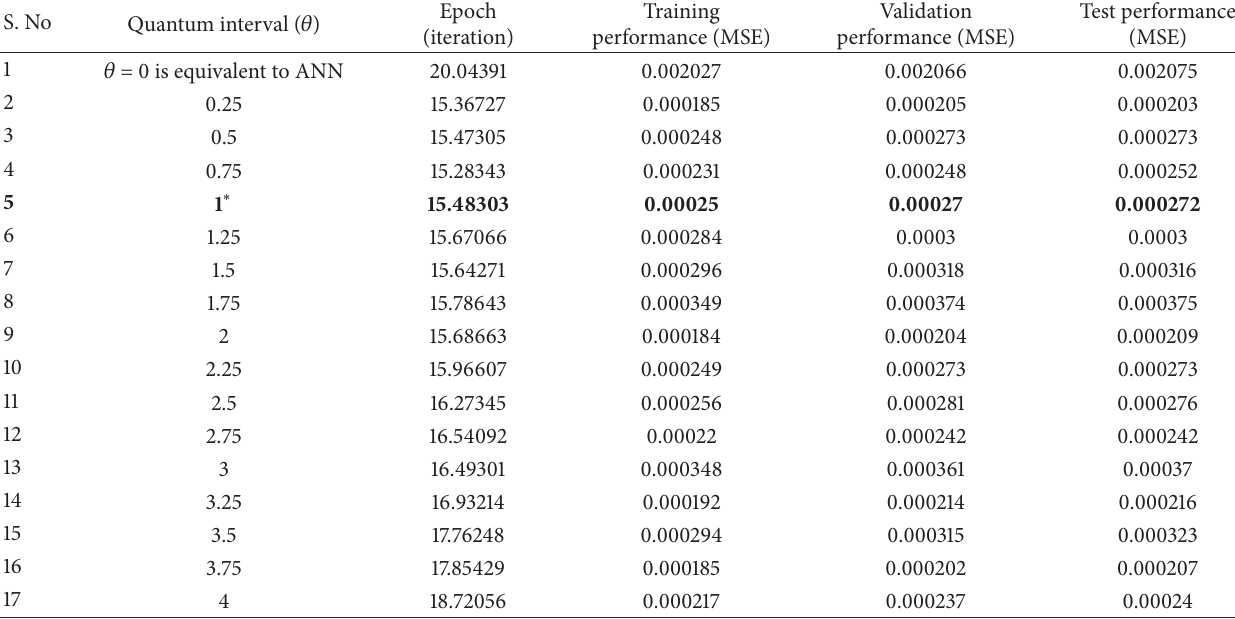
Table 2: Comparison of performance measurement of MT system with QNN and traditional neural network.